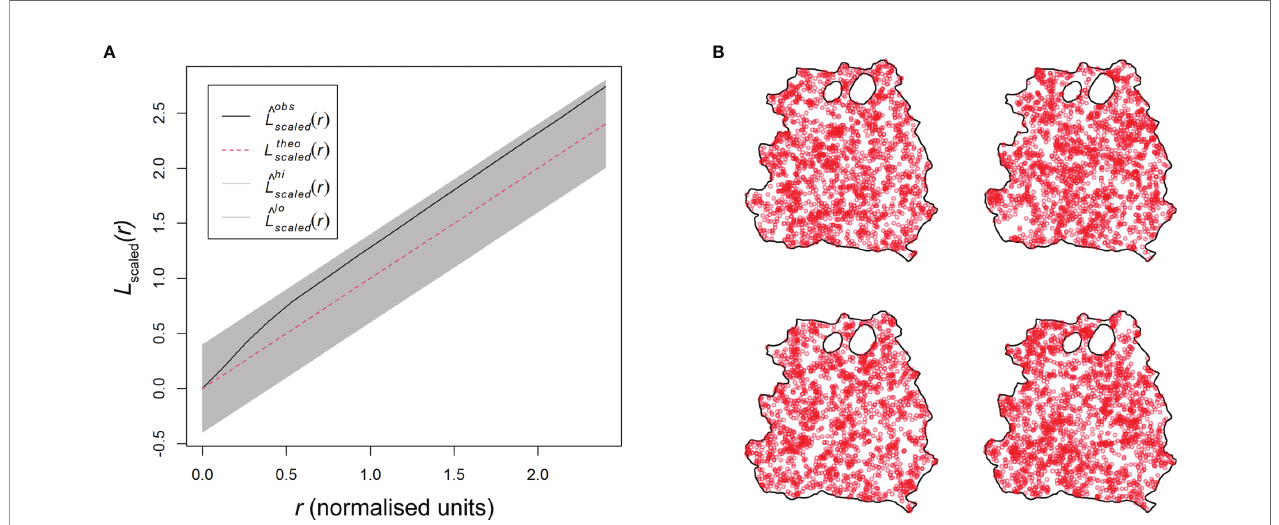
FIGURE 5 | Basic model evaluation of skin parasite patch distribution. (A) Scaled L-function showing the theoretical Poisson process (red dotted line), the RAG4 predicted model data (black solid line), and the global envelopes (gray). (B) Four model simulations based on the Mate ́ rn cluster process for